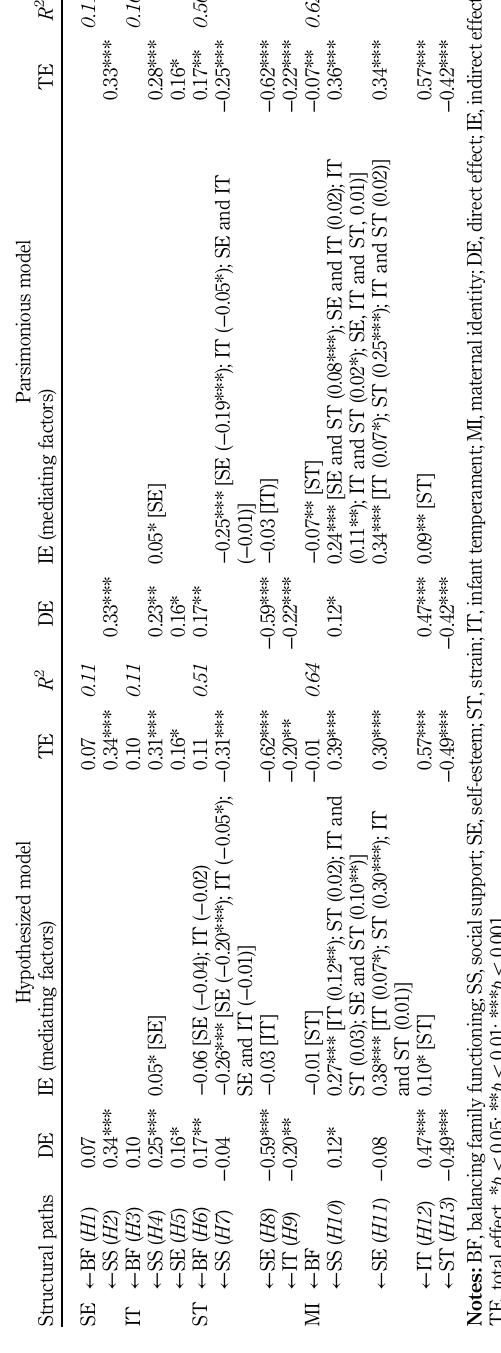
Table IV. Effects and mediating